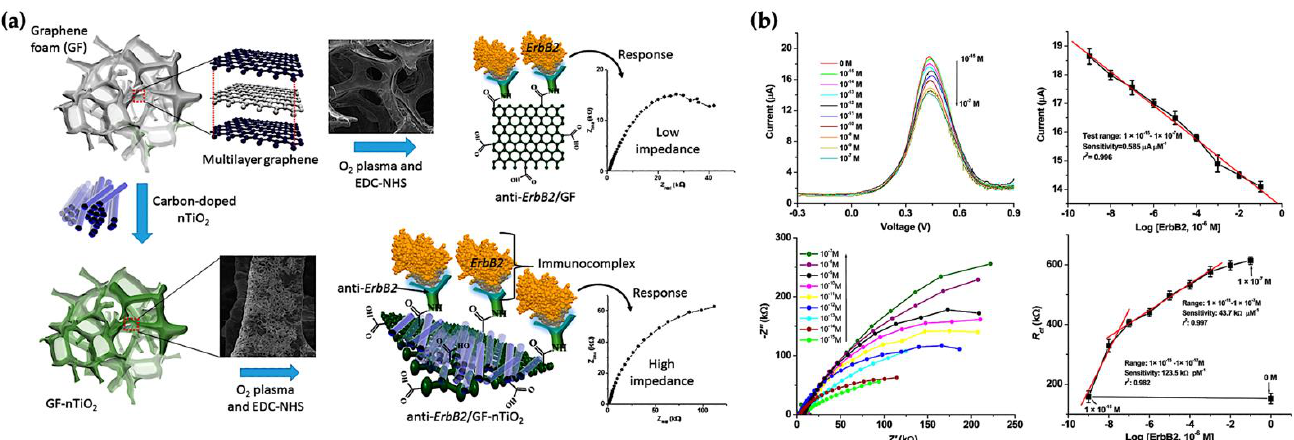
Figure 5. ( a ) Graphene foam (GF) and GF − nTiO2 electrodes; ( b ) DPV for different ErbB2 concentrations from 1.0 fM to 0.1 μM [95].